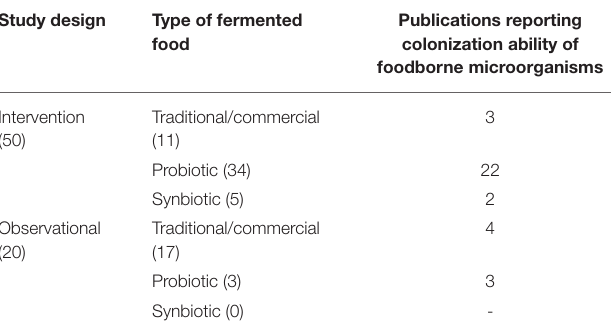
TABLE 1 | Classification of the publications included in the analysis based on study design, type of fermented food, and analysis of microbial colonization